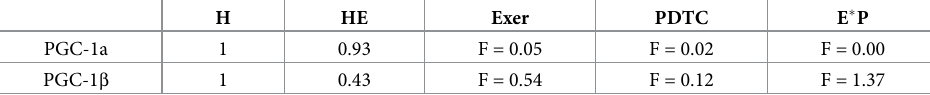
H = high-fat rat extensor digitorum longus muscle, HE = high-fat rat extensor digitorum longus muscle COX4 gene expression, Exer = high-fat rat extensor digitorum longus muscle COX4 mRNA expression, E � P = high-fat rat soleus muscle PDK4mRNA expression.Data represents the relative content of SPSS statistics.